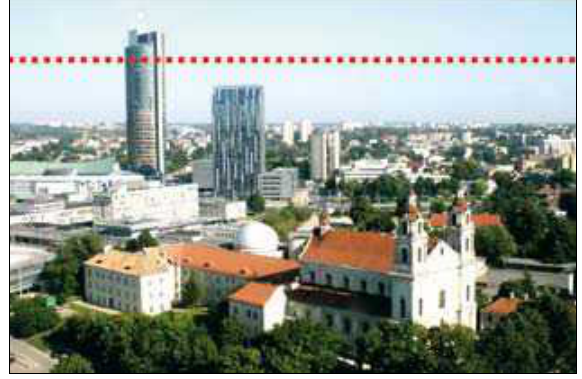
Fig. 9. An urban structure that was changed under the inf- luence of informal interaction causing to reduce the area of the Municipality and commercial building density (author’s